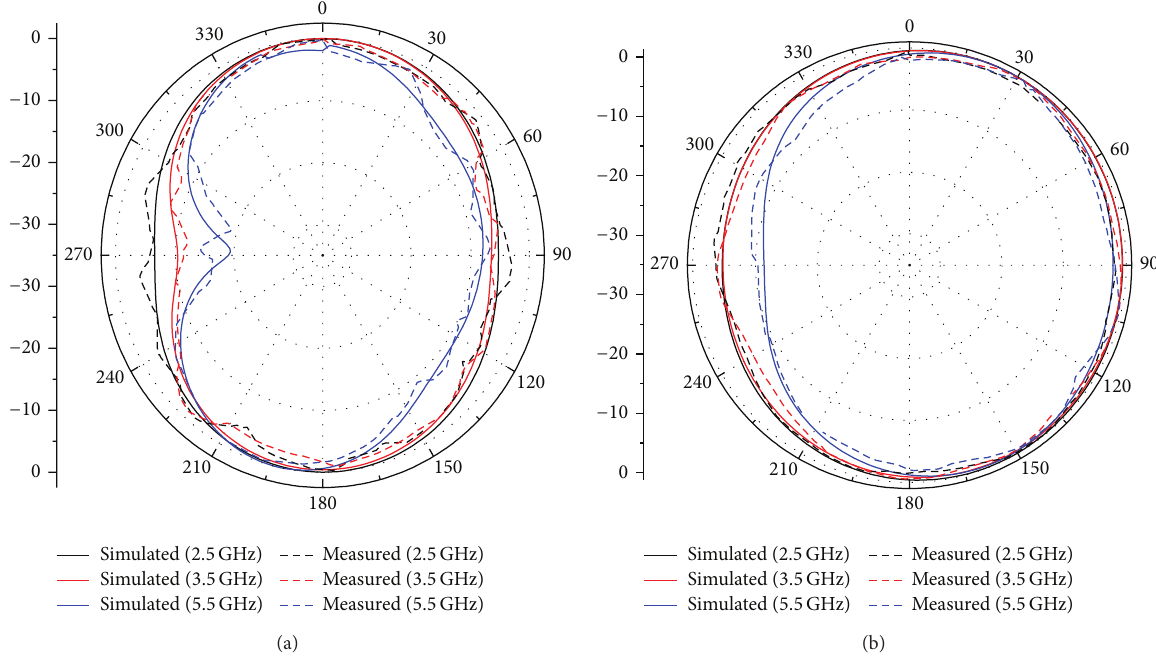
Figure 8: Simulated and measured normalized radiation patterns. (a) Simulated and measured normalized 𝑦 - 𝑧 plane at 2.5/3.5/5.5 GHz. (b) Simulated and measured normalized 𝑥 - 𝑧 plane at 2.5/3.5/5.5 GHz.